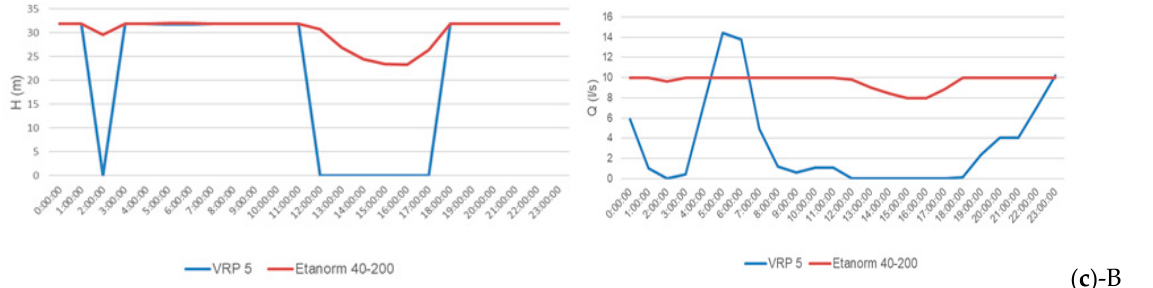
Figure 13. Hourly head and flow for: ( a ) normal; ( b ) high (with alternatives A-PAT1 and B-PAT1+2) and ( c ) very high (with alternatives A-PAT1 and B-PAT2) demand periods.